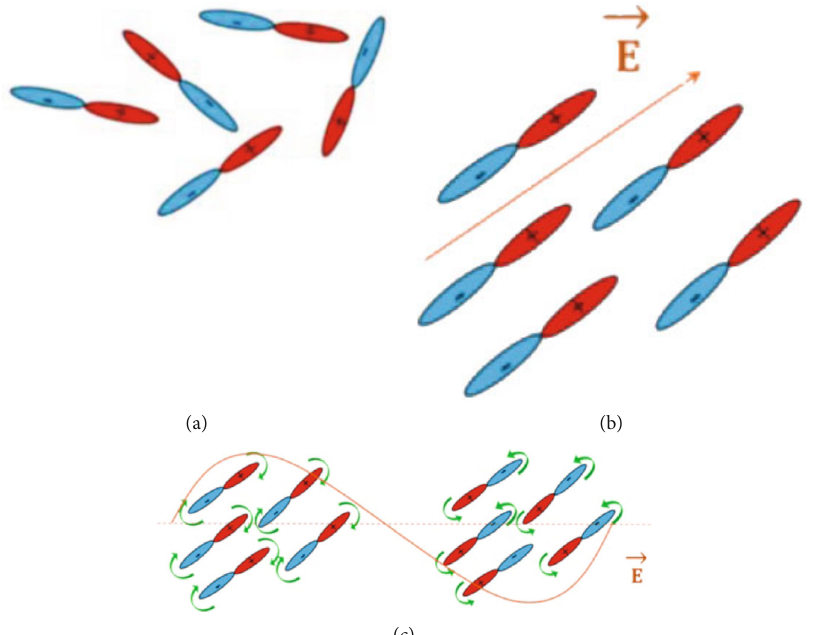
Figure 1: Orientation of dipoles (polar chemical moieties): (a) at rest; (b) in the presence of constant electric fi eld; and (c) in the presence of an alternative electric fi eld.